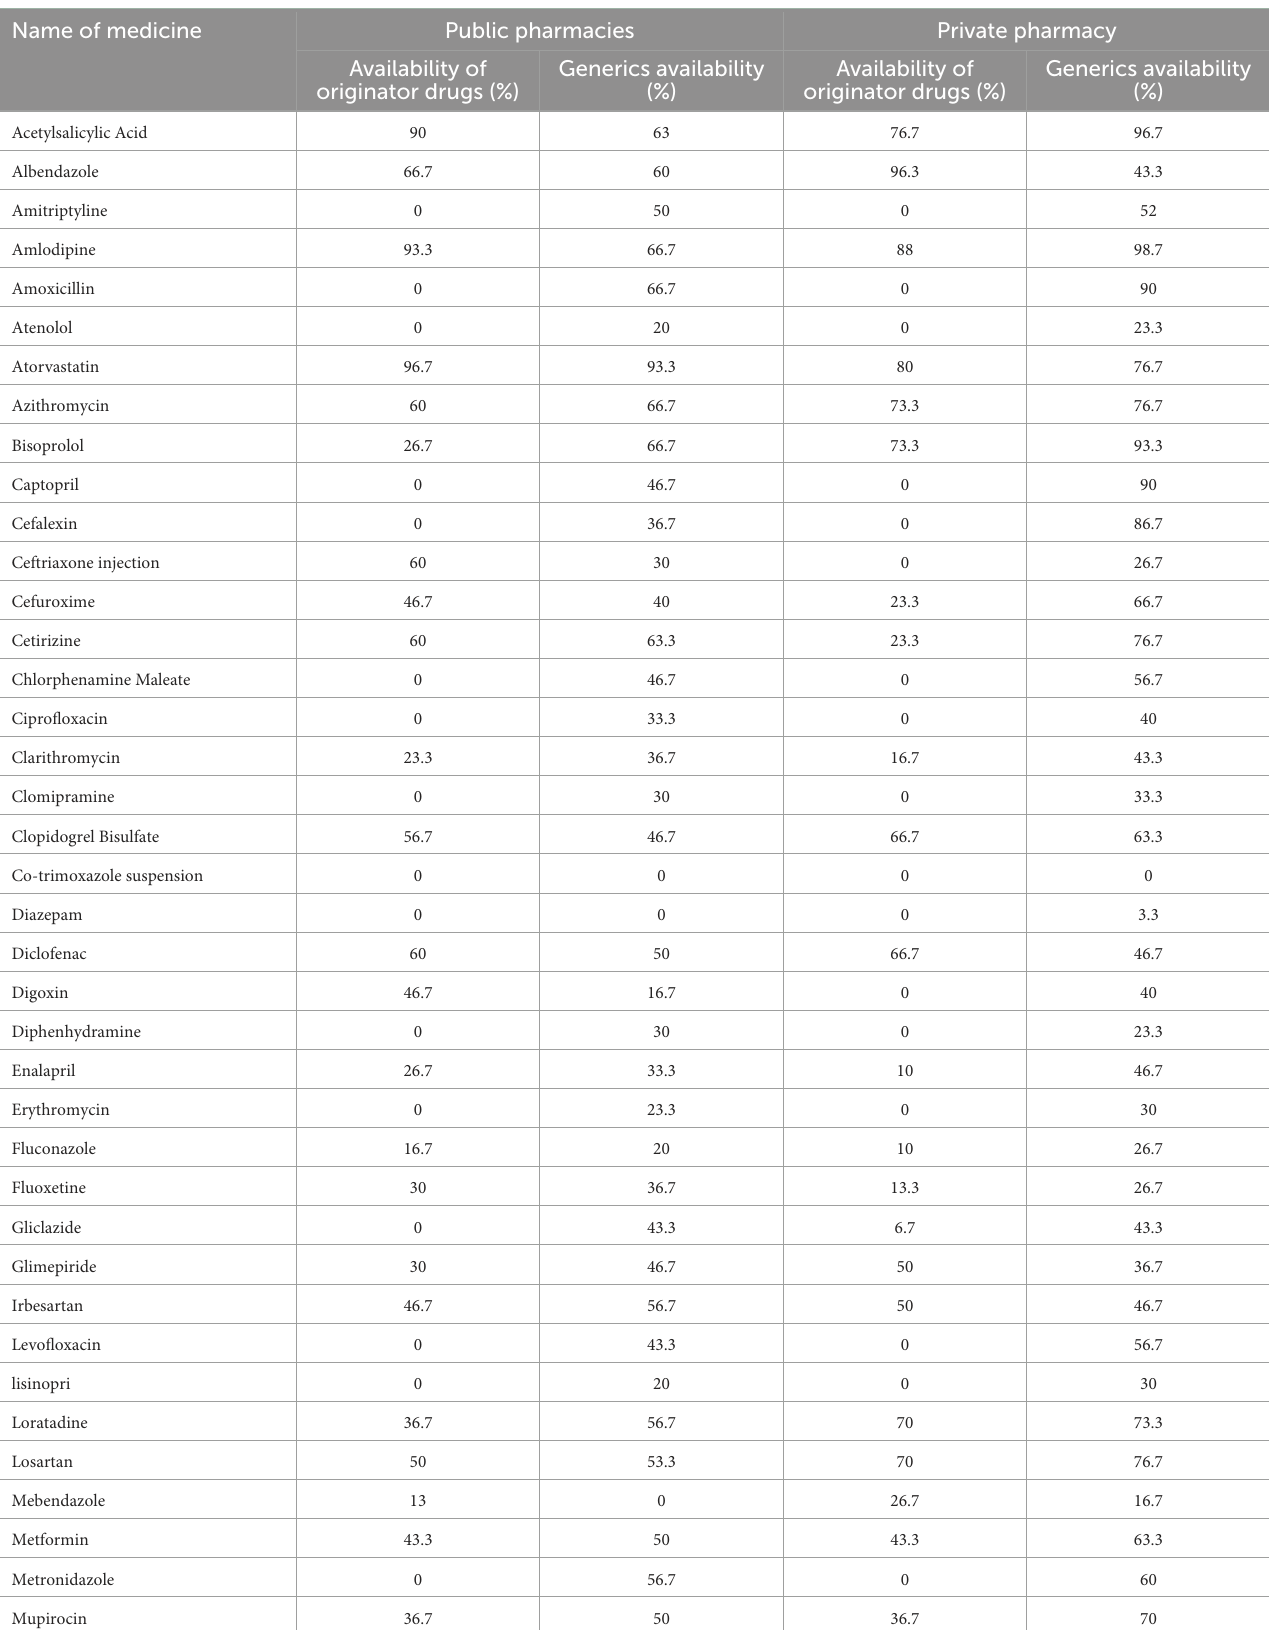
TABLE 1 Availability of individual medicines in public pharmacies and private